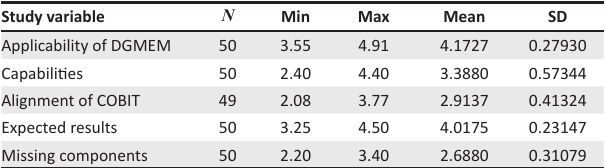
TABLE 8: Descriptive statistics of study variables. Study variable